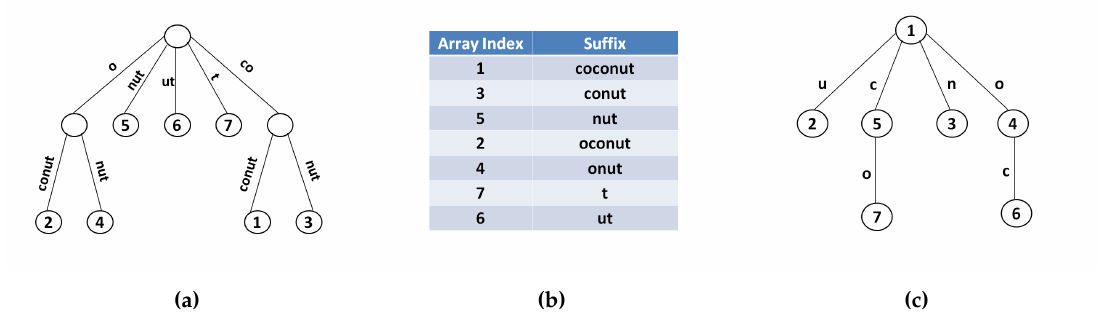
Figure 2. An example of the data structure constructed from the text “coconut”. ( a ) A suffix tree; ( b ) a suffix array; ( c ) a position heap